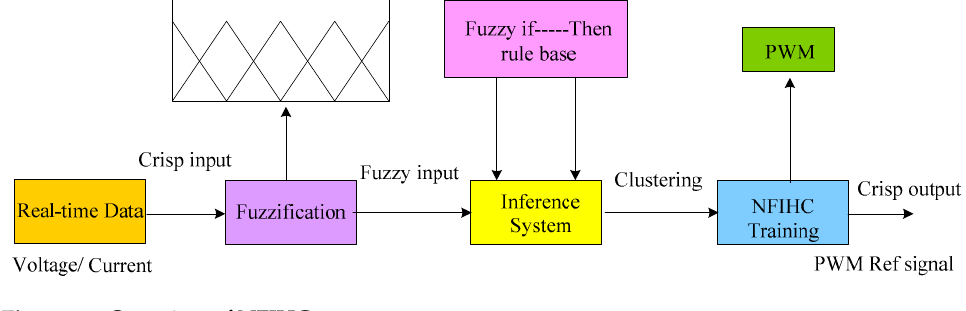
Figure 10. Overview of NFIHC.